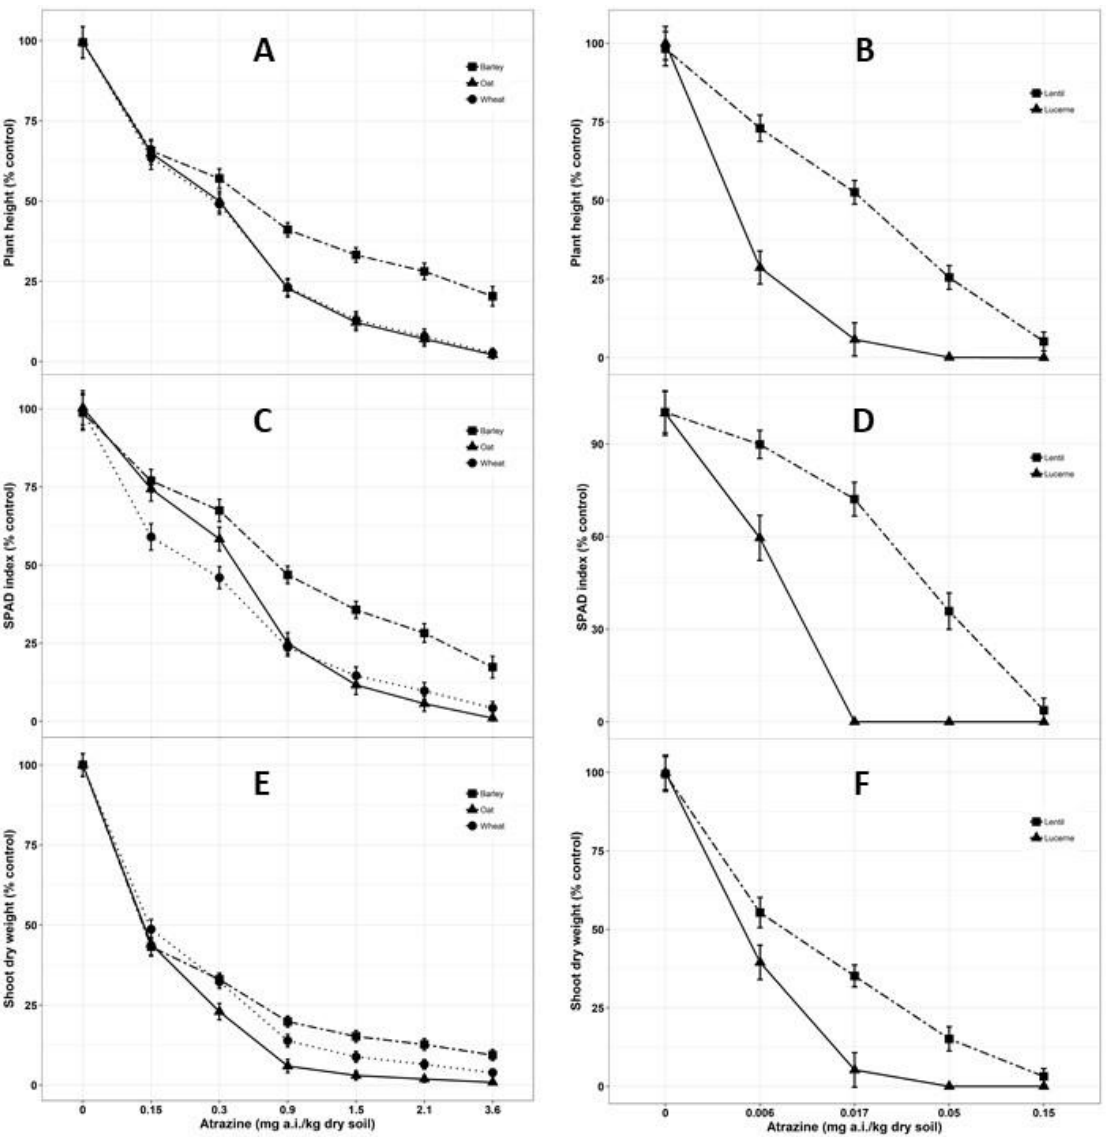
Figure 3. Dose-response assay of atrazine concentrations on plant height ( A . barley, wheat and oat; B . lentil and lucerne), SPAD index ( C . barley, wheat and oat; D . lentil and lucerne) and shoot dry weight ( E . barley, wheat and oat; F . lentil and lucerne) at 28 days after sowing (DAS). Lines denote predicted responses according to the equations reported in the materials and methods section. Symbols shown on the graphs are the original means of each parameters (% control) against each doses of atrazine concentration. Mean value was pooled from eight observational units for wheat, barley and oat; whereas four observational units for lentil and lucerne.